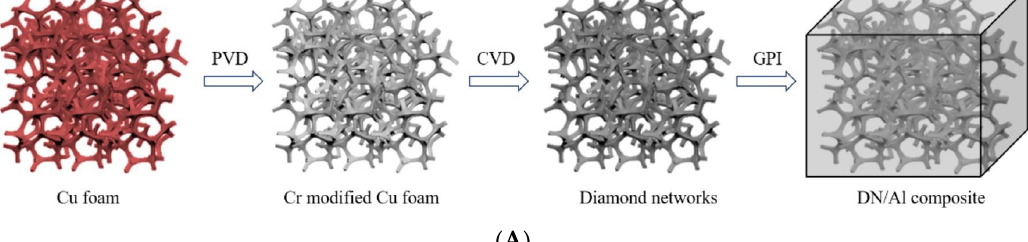
Figure 8. SEM micrographs demonstrating the occurrence of the diffusion reaction on the partial {111} faces of diamond particles in the gas pressure-infiltrated Al/diamond composites: ( a ) 800 °C and 0.8 MPa; ( b ) 850 °C and 0.5 MPa [126].